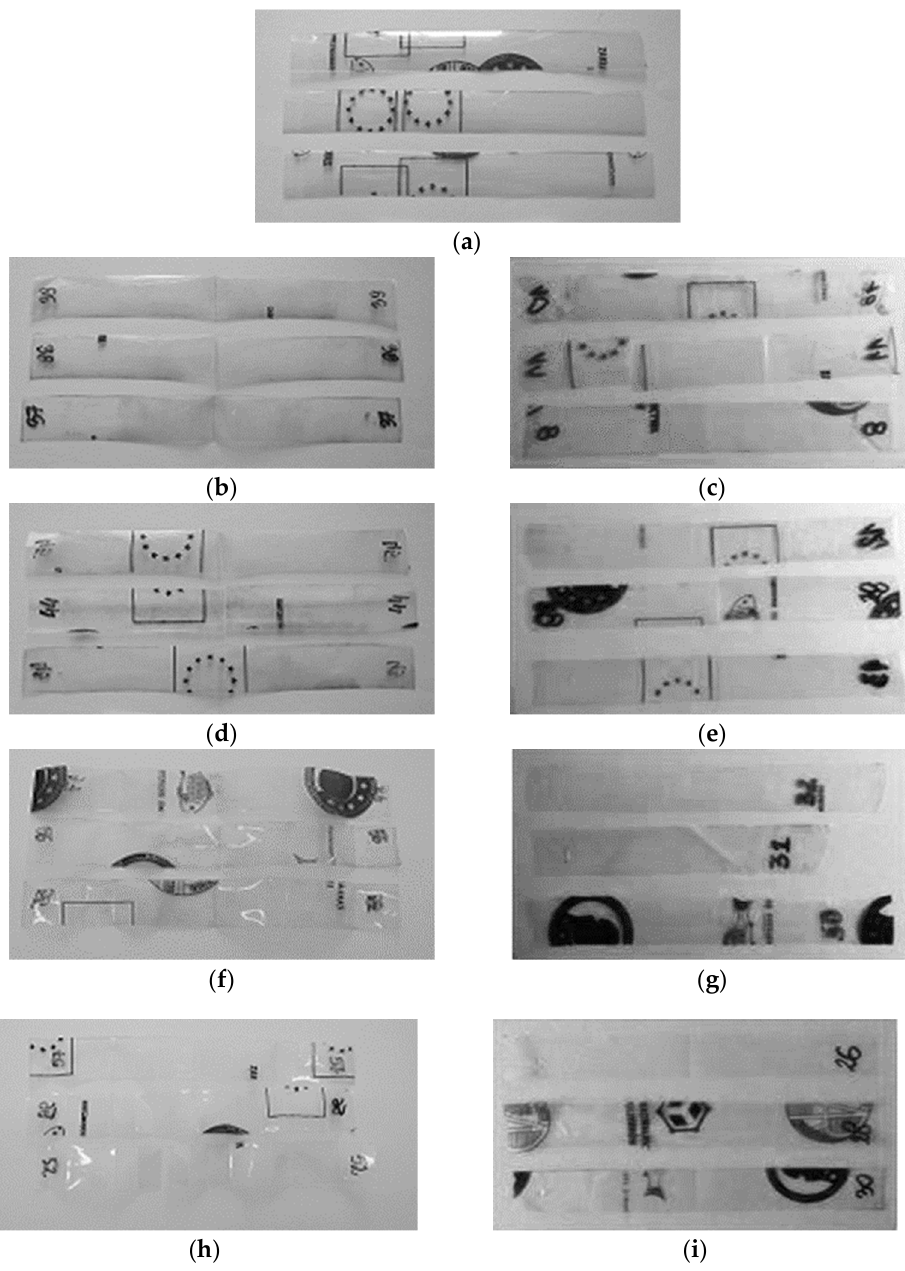
Figure 1. Macrographs of PLA samples before and after incubation in different aqueous environments: ( a ) before degradation; ( b ) 3 months in the pond; ( c ) 3 months in sea; ( d ) 6 months in the pond water; ( e ) 6 months in the seawater; ( f ) 12 months in the pond; ( g ) 16 months in the seawater; ( h ) 12 months in pond water + NaN 3 ; ( i ) 16 months in the seawater + NaN 3 . Source: Own research.